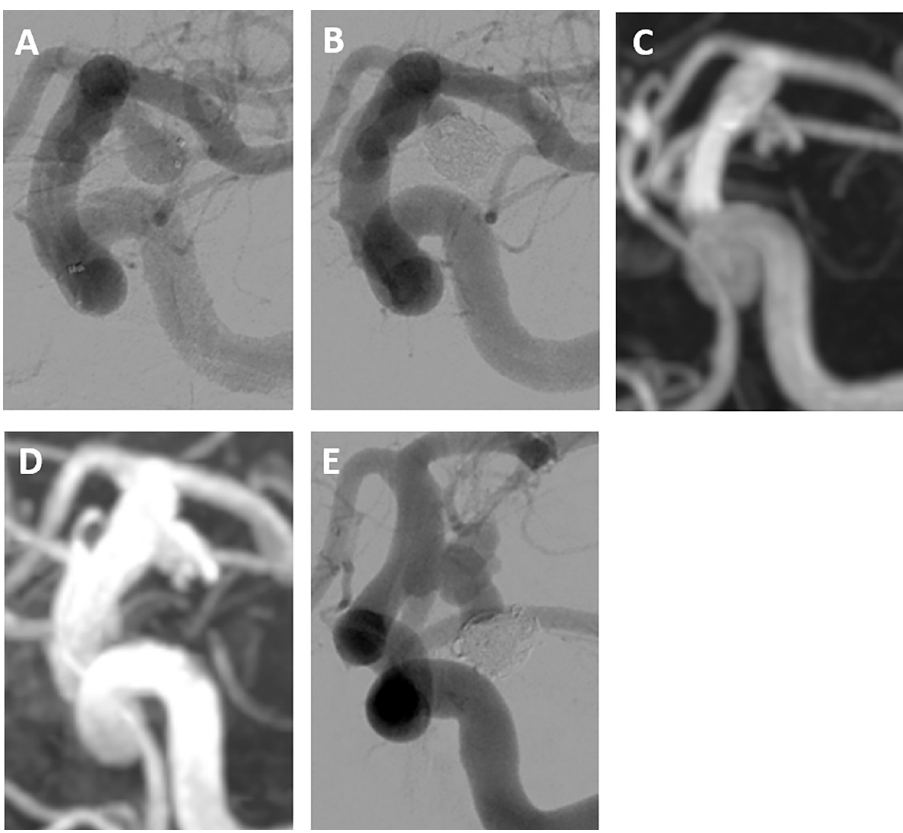
Fig 3. Recurrent hemorrhage after coil embolization of an intracranial aneurysm in a 64-year-old woman (case #2). (A and B) Posterior communicating artery aneurysm embolized using coils. Initial embolization was angiographically graded as MRRC class II, with a VER of 24.9%. (C) MRA at 2 years after coiling indicated a remnant neck. (D) MRA at 5 years after coiling indicated enlargement of the recurrent neck. (E) Re-hemorrhage at 7 years after coiling, with angiography indicating the formation of a daughter